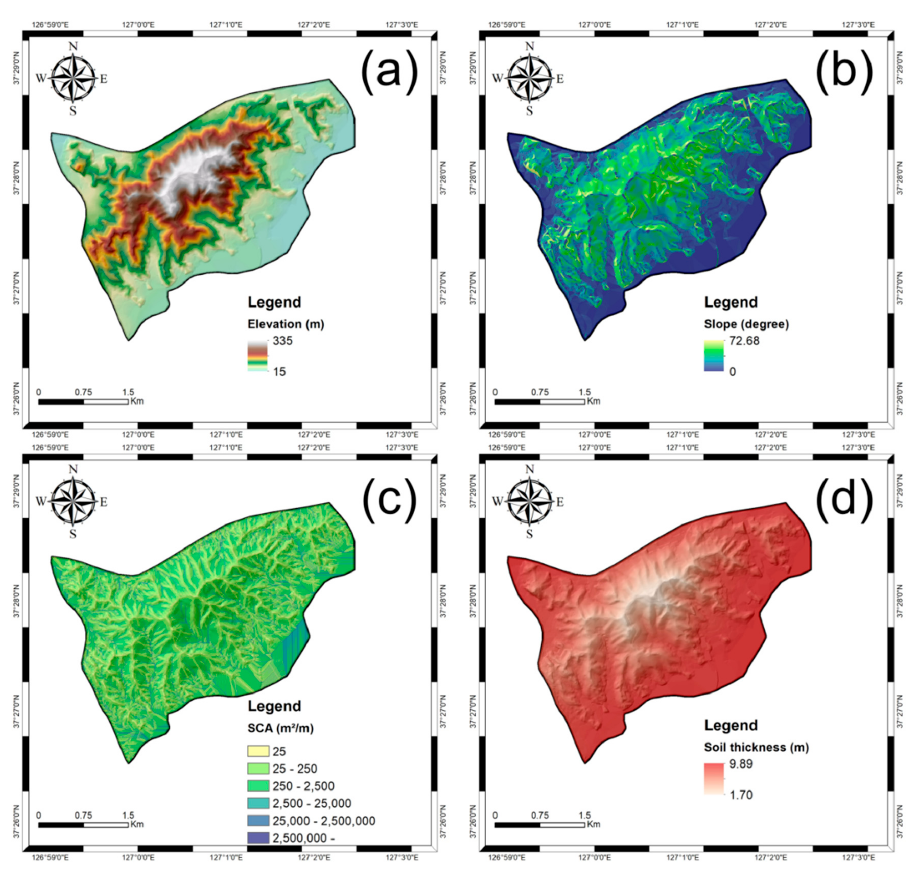
Figure 4. Map showing the input parameters constructed using topographic maps: ( a ) elevation; ( b ) slope; ( c ) specific catchment area (SCA); ( d ) soil thickness. Remote Sens. 2020 , 12 , x FOR PEER REVIEW